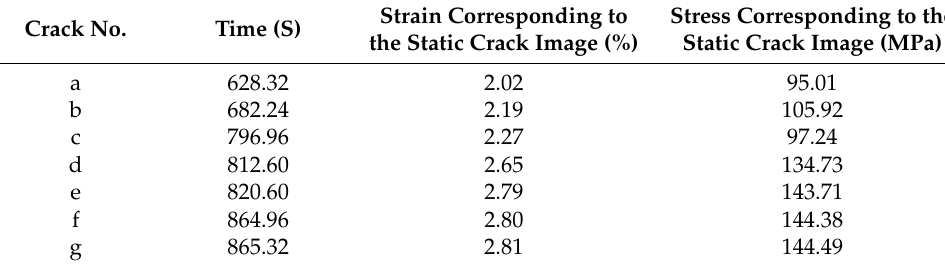
Table 4. Stress and strain values corresponding to the static crack images. Crack